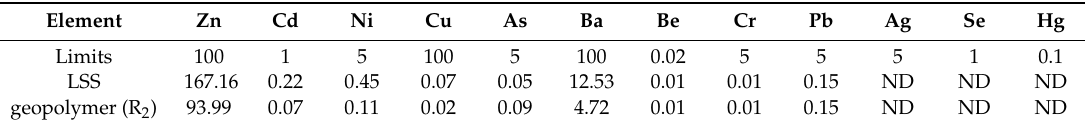
Table 4. Toxicity characteristic leaching procedure (TCLP) results of the LSS and geopolymer (R 2 ) cured for 28